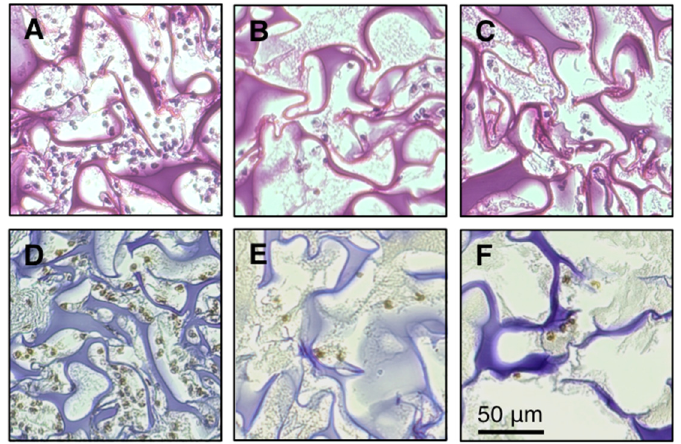
Figure 3. H & E staining and immunohistochemical detection of 8-OHdG at the inflammatory site. Histological sections were obtained from the mice five days after co-implantation of QR-32 cells with gelatin sponge. ( A , D ), tissues from basal diet group; ( B , E ), from 5% FBRA group; ( C , F ), from 10% FBRA group; ( A – C ) were stained with H & E. Immunohistochemistry was performed with antibody against 8-OHdG ( D – F ). Scale bar, 50 µ m.